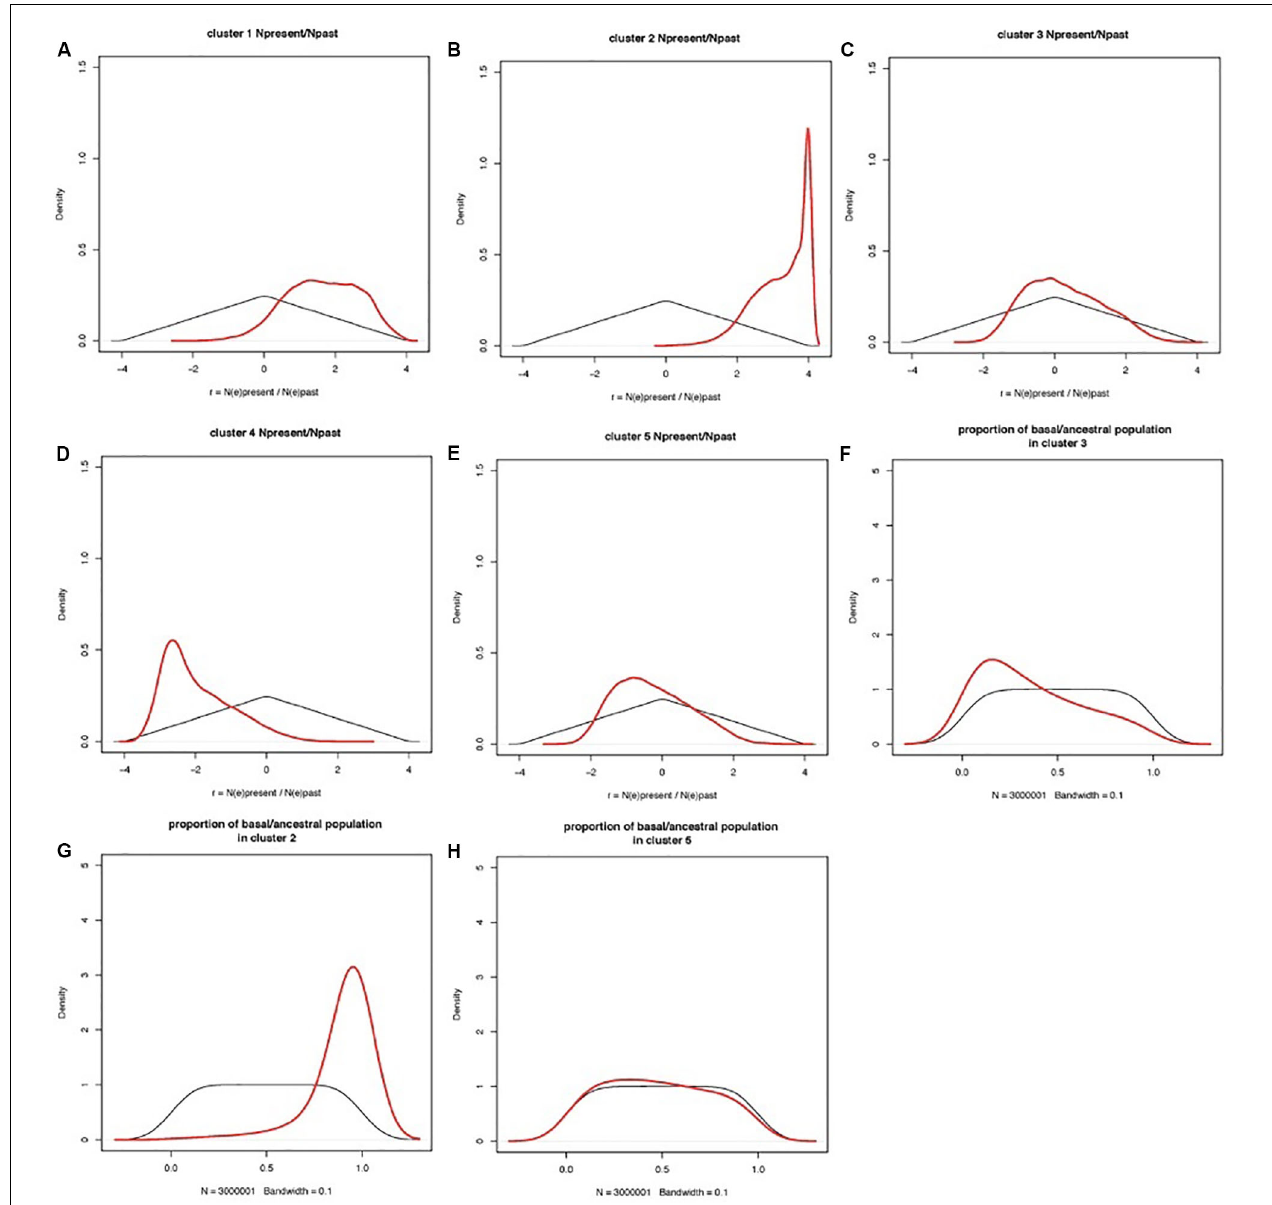
FIGURE 6 | Prior and posterior distributions of evolutionary parameters estimated by coalescent-ABC modeling in DIYABC. Clusters are defined by STRUCTURE analysis as in Figure 1 . (A–E) Prior and posterior distributions of r = N E ( present ) /N E ( past ) for each cluster, with N E ( present ) = current effective population size, N E ( past ) = effective population size before the demographic change. r is shown on a log(10) scale, so that a posterior peak at zero indicated no demographic change, a posterior peak at negative values suggests a population bottleneck (i.e., current population smaller than past population), and a posterior peak at positive values suggests a population expansion (i.e., current population larger than past population). (F–H) Population admixture ratios. Thin black lines: prior distributions; thick red lines: posterior